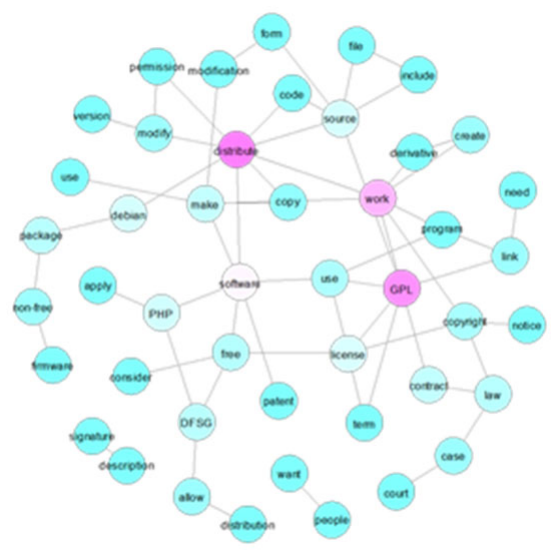
Figure 3. The co-occurrence network graph